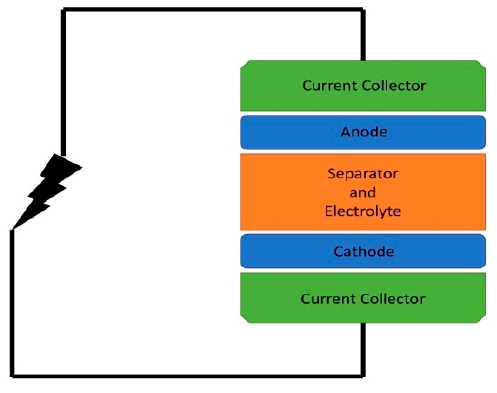
Figure 9. Diagram of the Li-ion